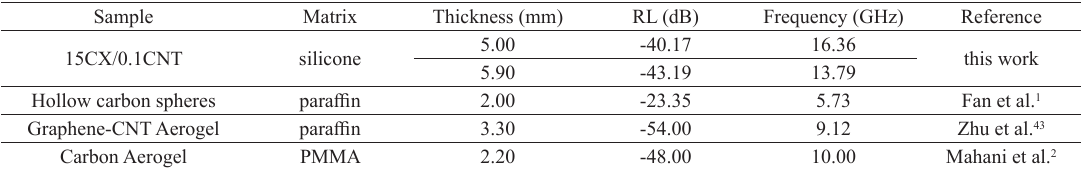
Table 3. Electromagnetic properties of carbon gels.